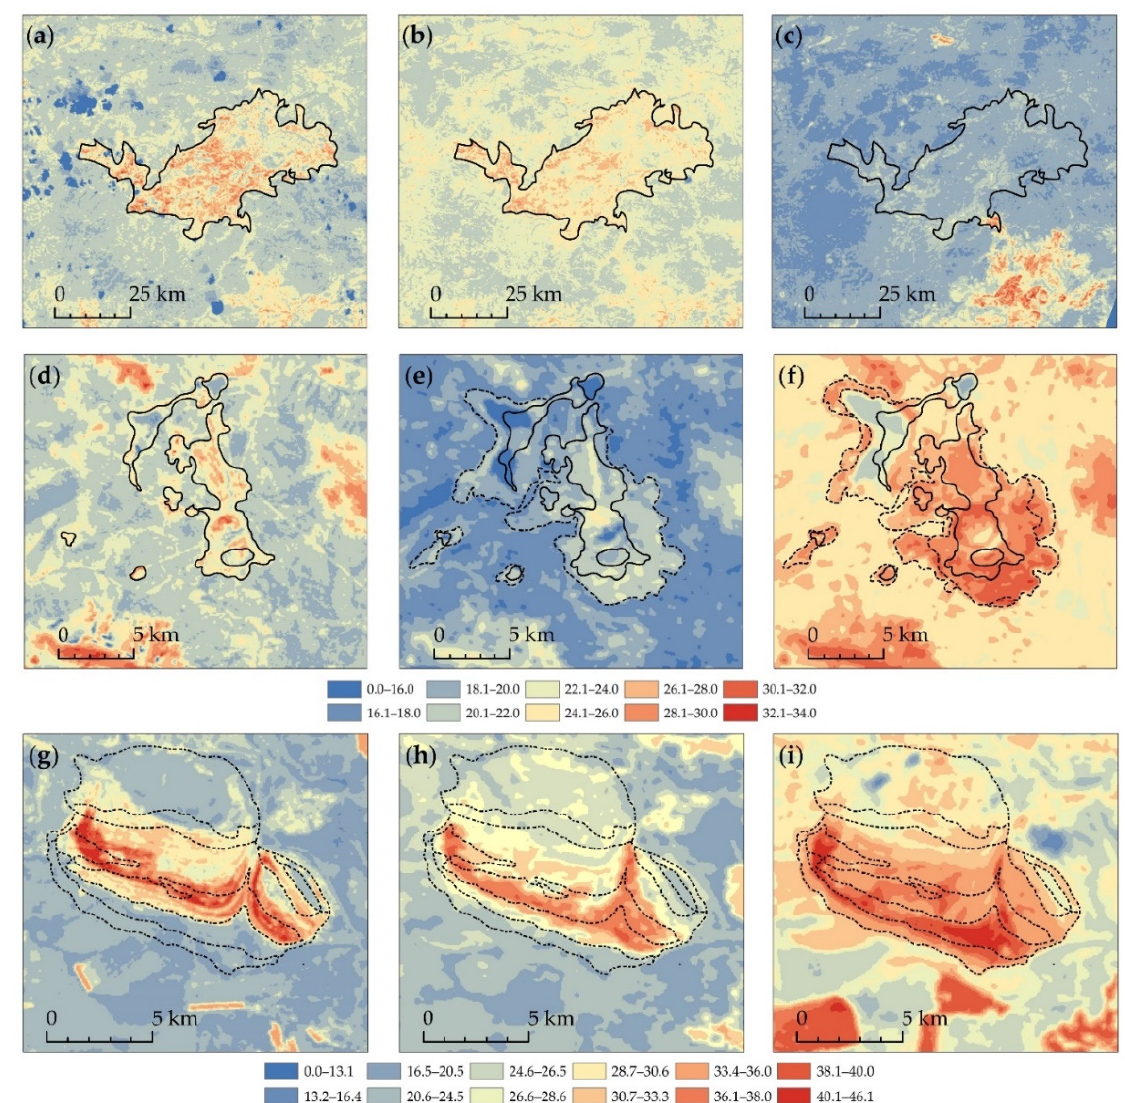
Figure 3. Time series of satellite data on surface temperature in July for (1) post-fire plot in 1997 after 1-years recovery ( a ), 10-years recovery in 2006 ( b ), and 20-years recovery in 2016 ( c ); (2) OMP plot with the identification of zones of different ages (since 2000) formation of a technogenic ecosystem on dumps in ( d ) 2000, ( e ) 2011, and ( f ) 2019; and (3) BCM plot with the identification of zones of different ages (since 1960–1970th) formation of a technogenic ecosystem with reclamation in ( g ) 2000, ( h ) 2010, and ( i ) 2018.